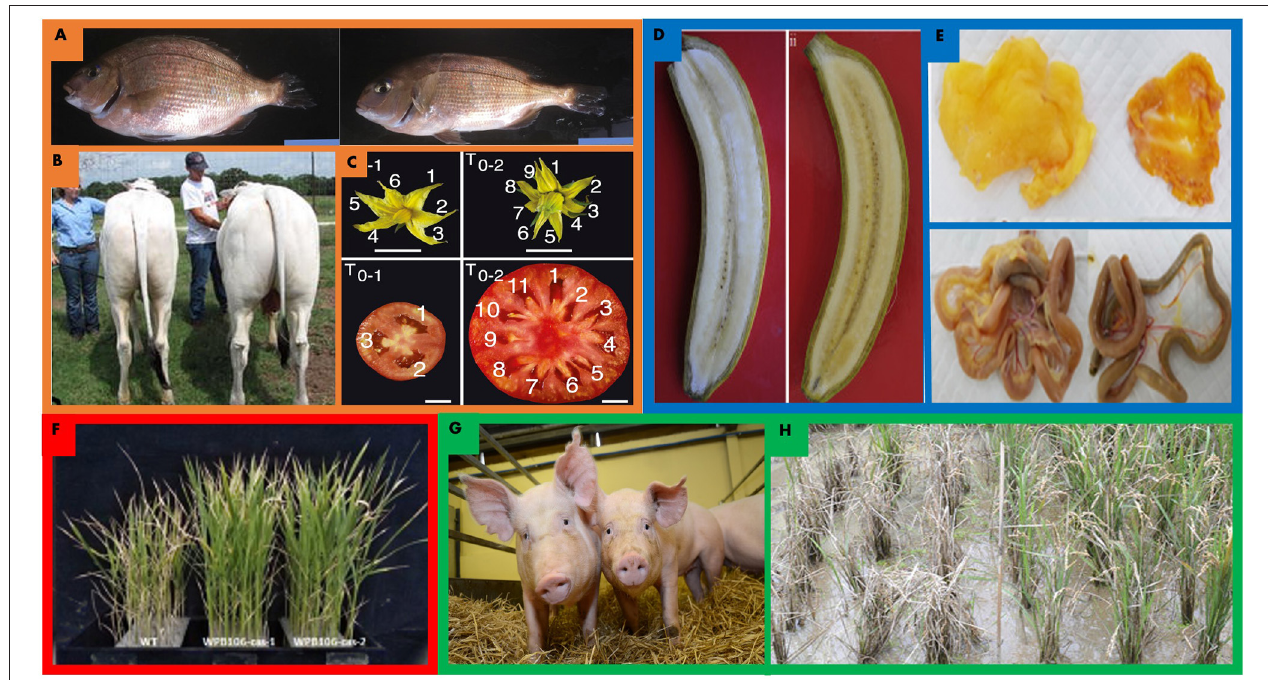
FIGURE 2 | Gene editing improvements for land sparing in orange, nutrition in blue, abiotic stress tolerance in red, and disease in green. (A,B) MSTN gene edits in livestock enhance muscle yields in a variety of organisms. (B) CRISPR/Cas9 mediated MSTN edited red sea bream (left) and wild type (right) ( Kishimoto et al., 2018). Edited red sea bream exhibited 16% skeletal muscle mass increases on average. (C) TALEN enabled MSTN edited cow (right) and wild type (left) exhibit increased overall mass and greater muscle mass ( Proudfoot et al., 2015). (C) CRISPR/Cas9 promoter editing of tomato CLV3, S, SP facilitated novel variation and enhancements to fruit size, floral architecture and overall architecture in tomato. Edited tomato (right) exhibits enlarged fruit size and increased locule number (Rodríguez-Leal et al., 2017 ). (D) CRISPR/Cas9 edited LCY ε enhanced beta-carotene accumulation in edited banana (right) relative to wild type (left) by nearly six fold in some lines